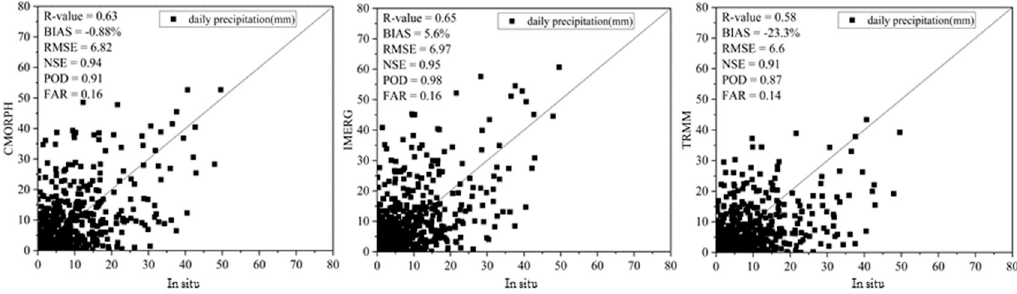
Figure 4. Comparison of the daily precipitation data from satellite-based products with in situ observations.